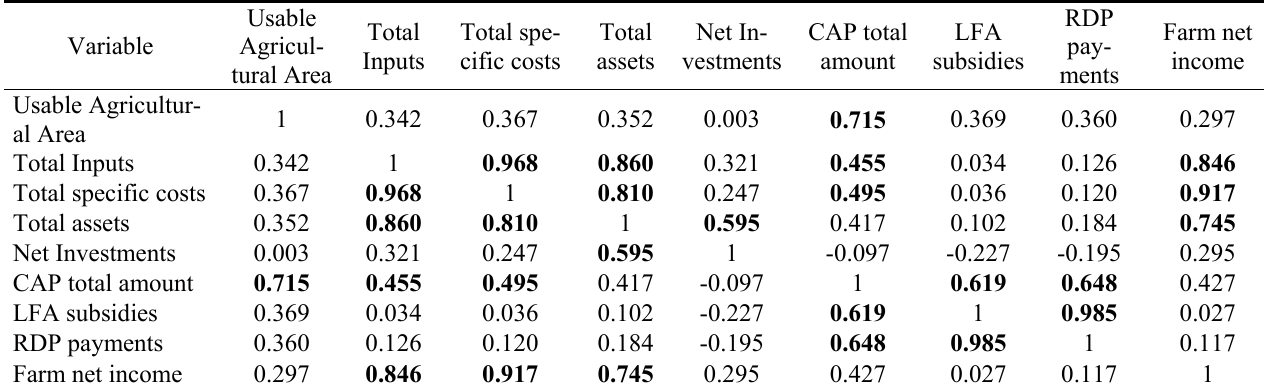
Main correlations among all investigated variables year 2004. In bold are values of significance at 5% (Source: author’s elaboration on data